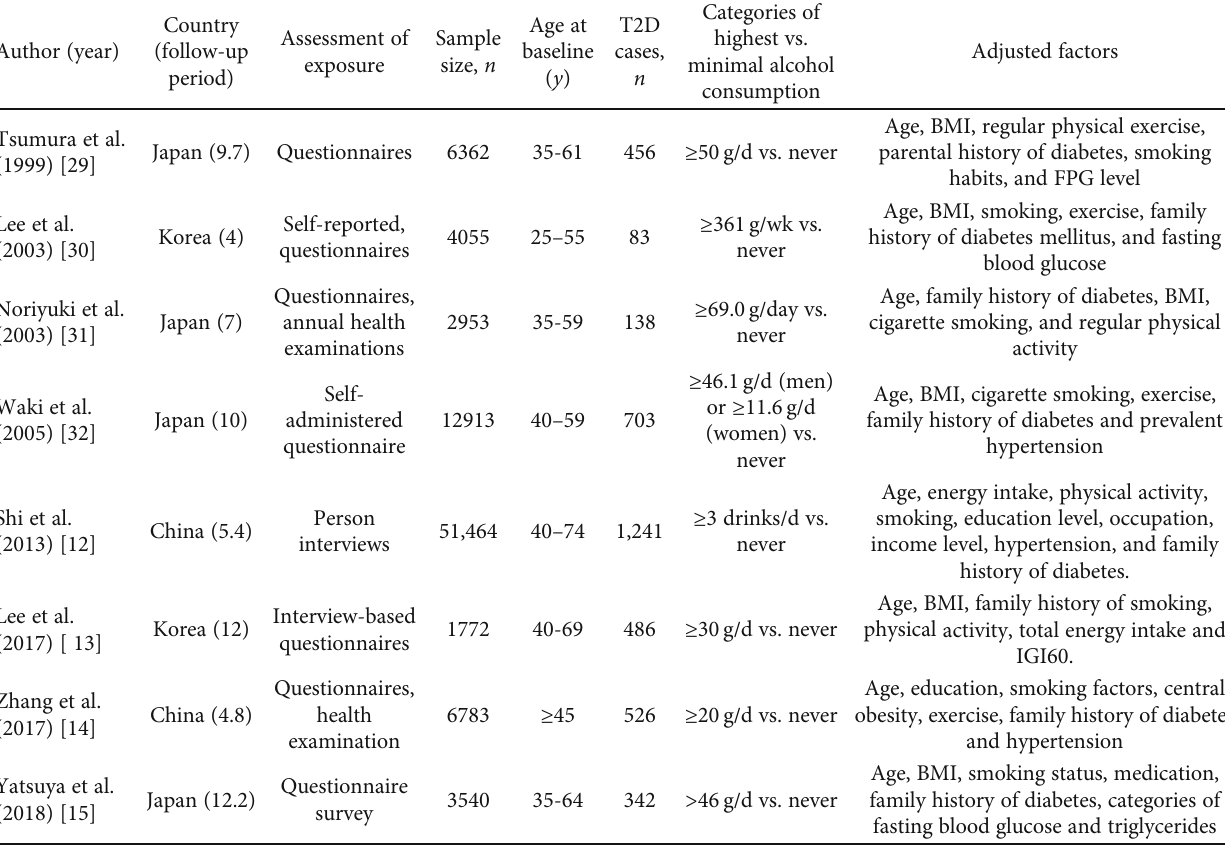
Table 1: Characteristics of participants and follow-up in included studies of alcohol consumption in relation to risk of T2D. Author (year)